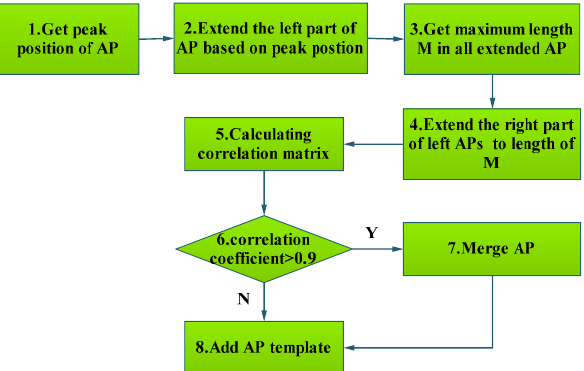
Figure 2. Flowchart of AP peak alignment.